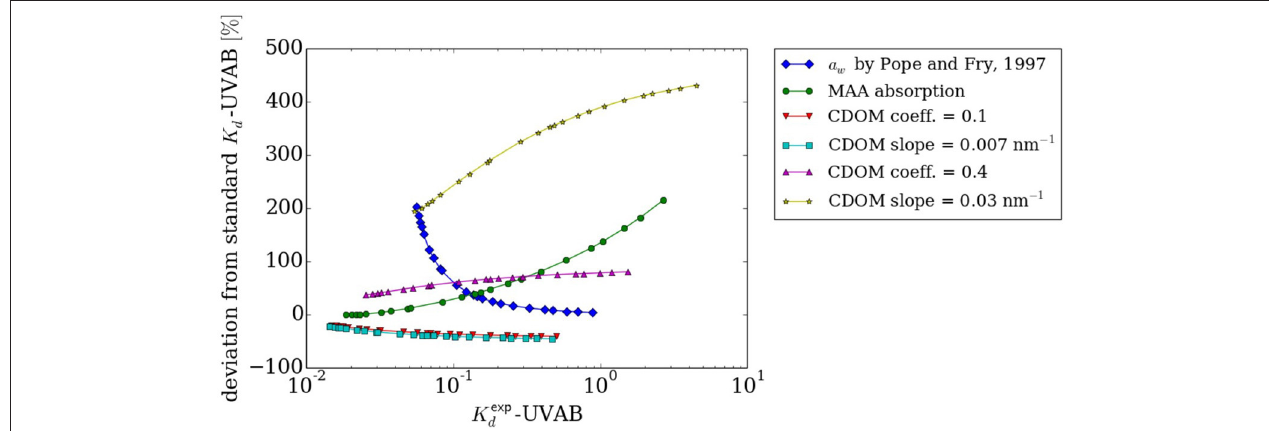
FIGURE 9 | Deviation of K exp d -UVAB as in the modified scenario from K d -UVAB in the standard scenario as function of K exp d -UVAB for tested variations in oceanic